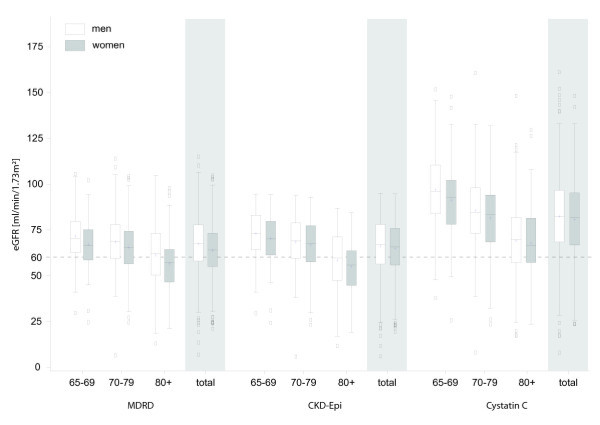
Boxplots of eGFR based on different estimating equations for men and women in different age groups (values lower than 60 ml/min/1.73 m2 indicating chronic kidney disease stages 3–5; + denoting mean values).